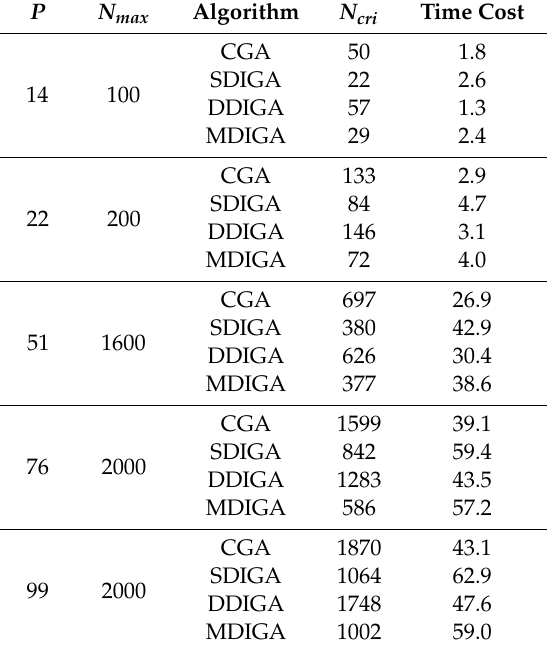
Table 6. Simulating results of computing efficiency for each algorithm.